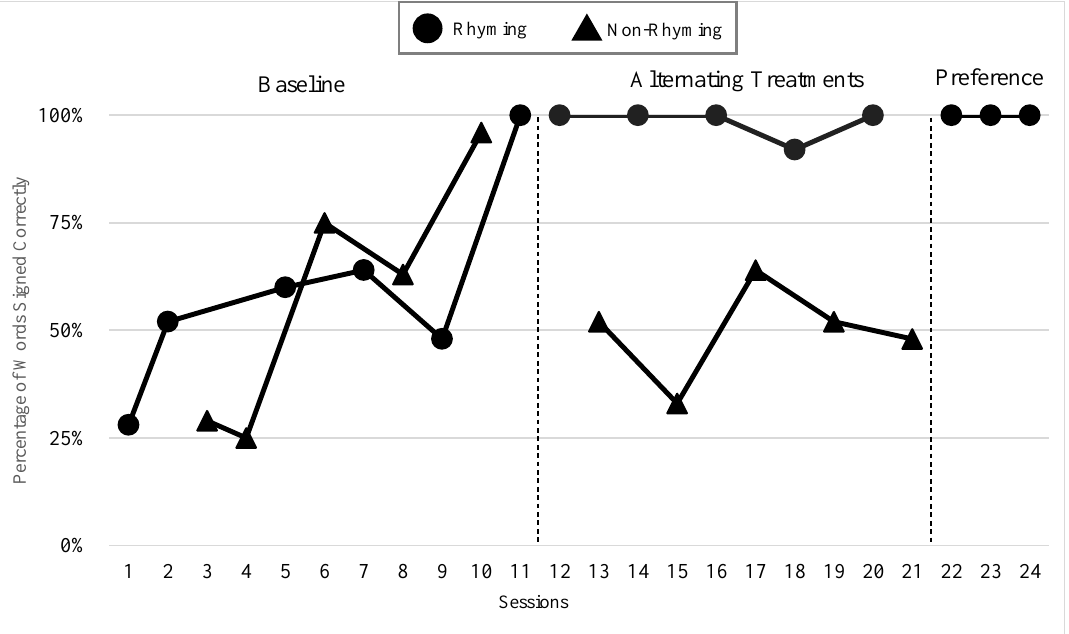
Figure 13. Jaslene’s Percentage of Words Signed Correctly in Recitation.